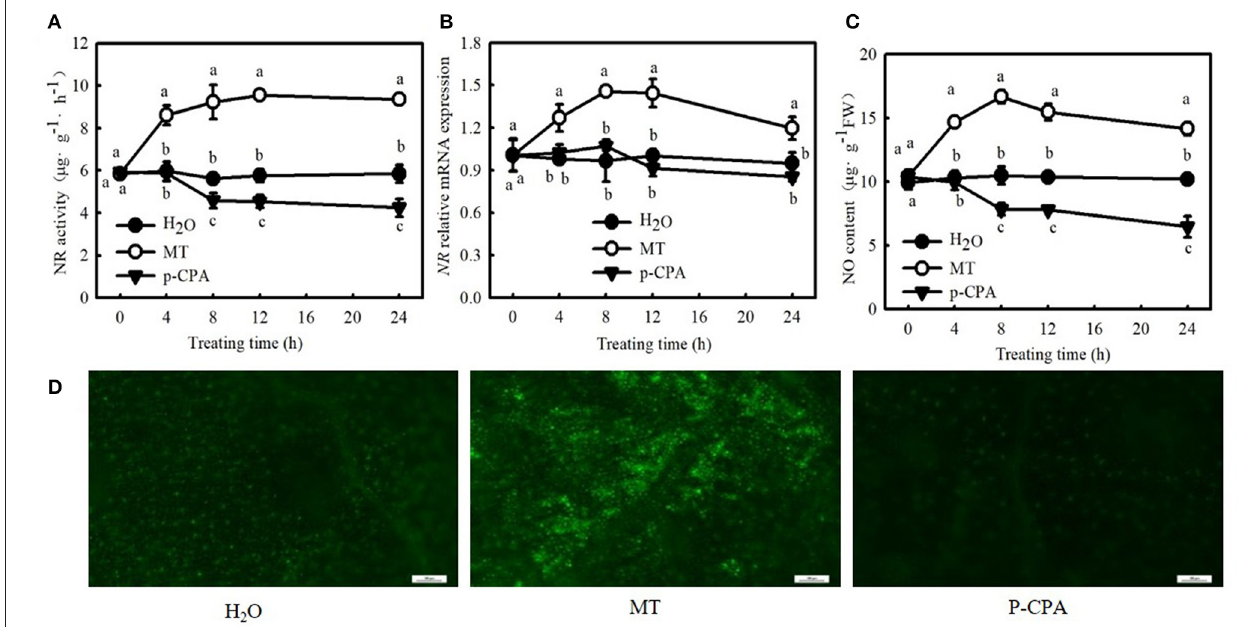
FIGURE 4 | Effects of MT on the nitrate reductase (NR) activity, NR- relative mRNA expression, and nitric oxide (NO) content in cucumber seedlings under normal temperature. (A) NR activity; (B) NR- relative mRNA expression; and (C) NO content. Three-leaf stage seedlings were foliar sprayed with 100 µ M MT, 50 µ M p-CAP (a biosynthetic inhibitor of MT), or distilled water (control) for 24h. (D) NO inverted fluorescence microscope imaging at 25 ◦ C for 8h. Data are represented as mean ± SD ( n = 3). Different letters indicate a significant difference between samples according to Duncan’s new multiple range test ( p < 0.05).